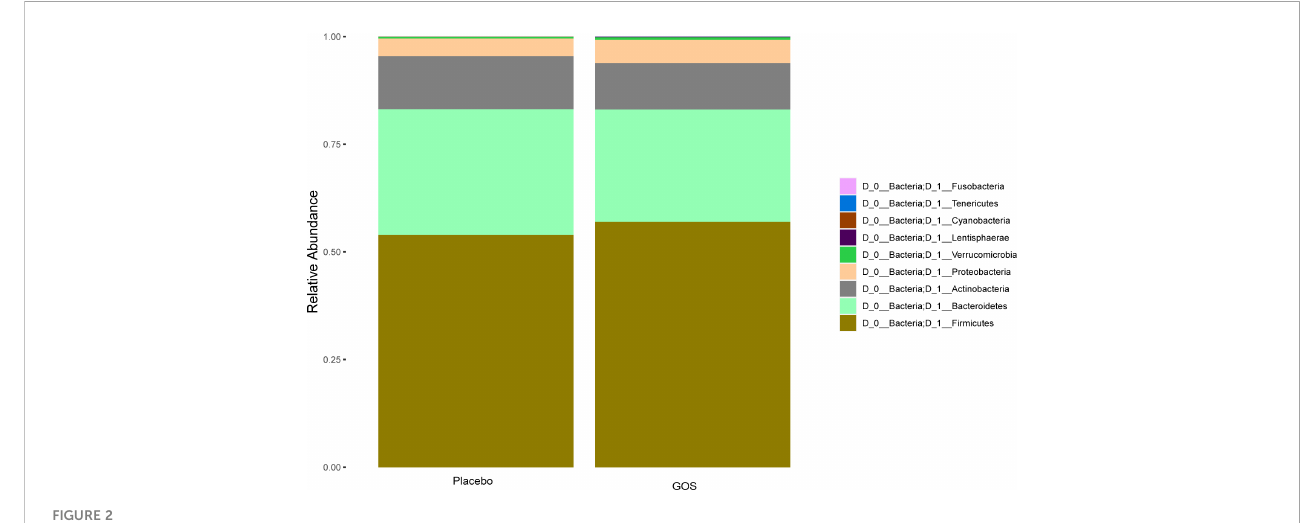
FIGURE 2 Relative abundance at the level of bacterial